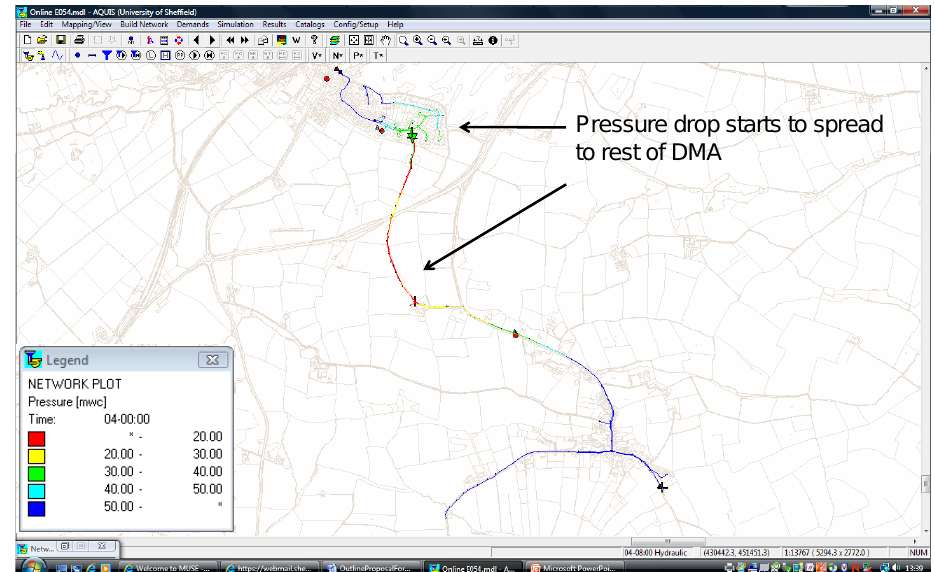
Figure 5. Pressure e ff ect of event at